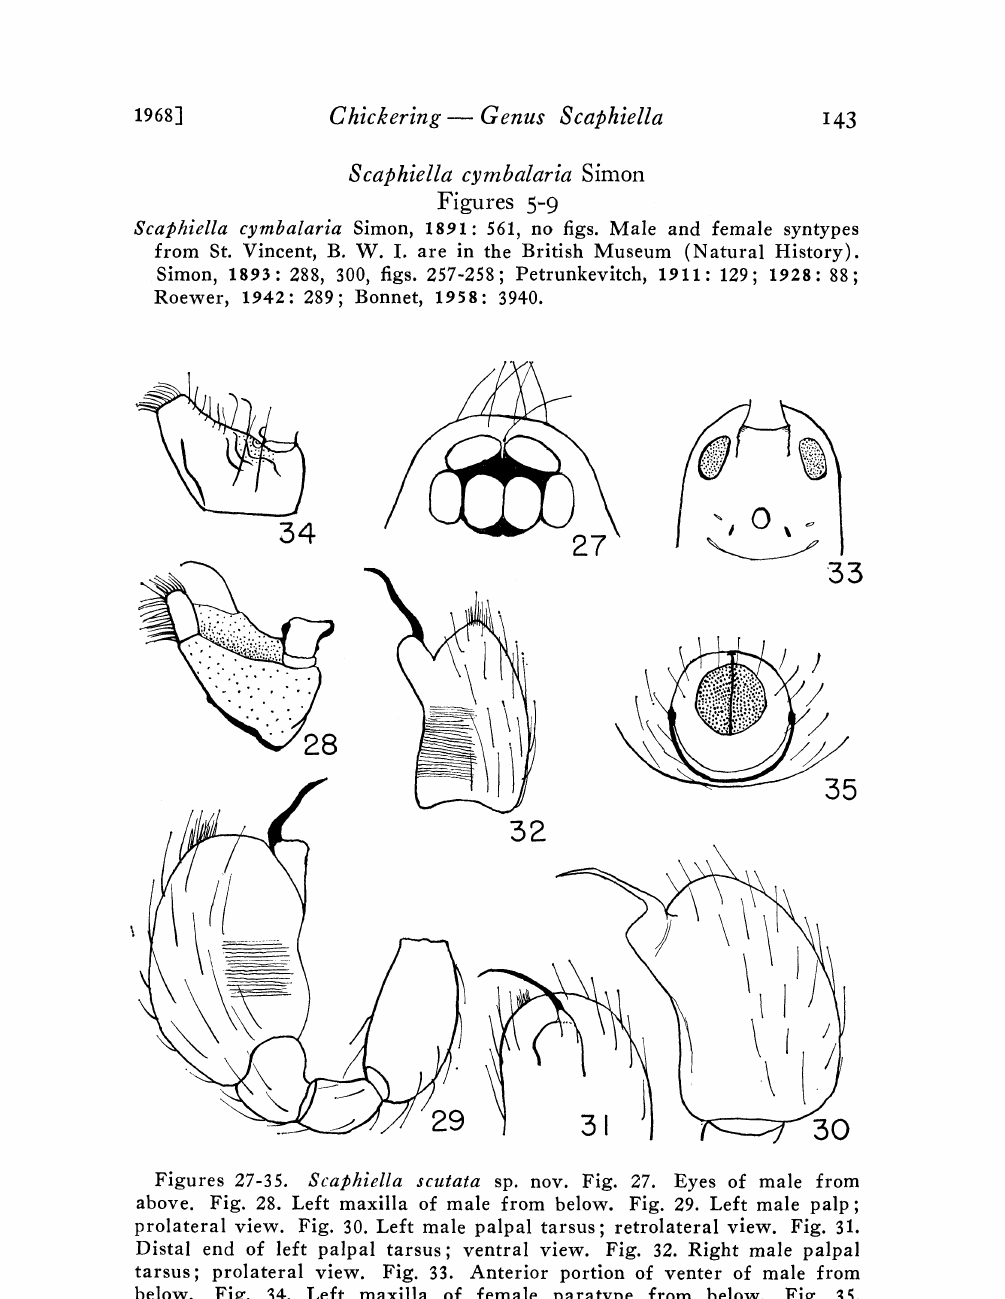
Figures 27-35. Scaphiella scutata sp. nov. Fig. 27. Eyes of male from above. Fig. 28. Left maxilla of male from below. Fig. 29. Left male palp; prolateral view. Fig. 30. Left male palpal tarsus; retrolateral view. Fig. 31. Distal end of left palpal tarsus; ventral view. Fig. 32. Right male palpal tarsus; prolateral view. Fig. 33. Anterior portion of renter of male from below. Fig. 34. Left maxilla of female paratype from below. Fig. 35. Epigynal area from